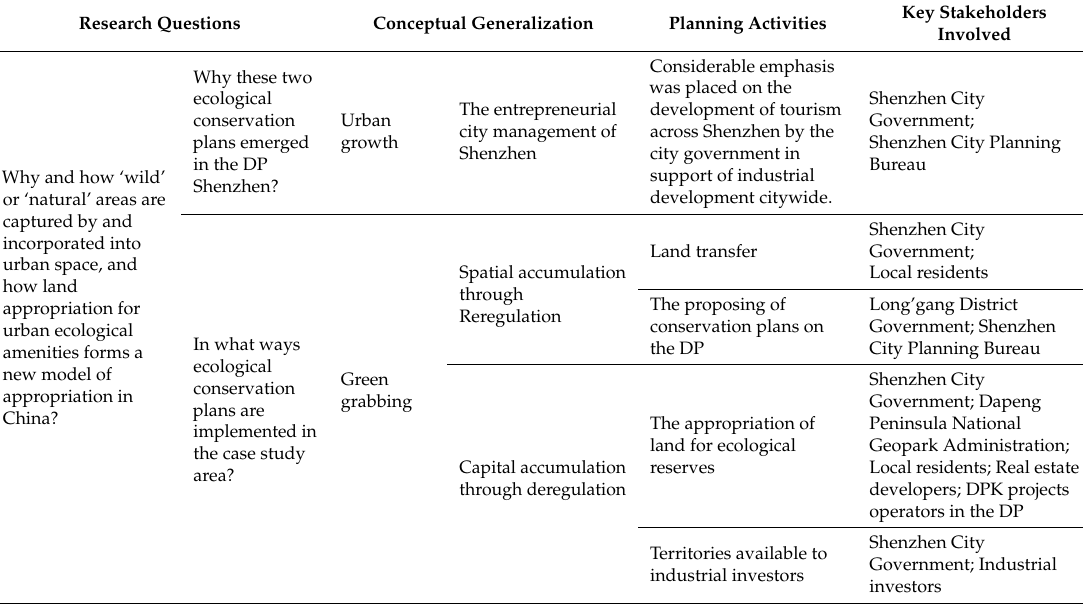
Table 2. How research questions lead to conceptual generalization of planning activities in the